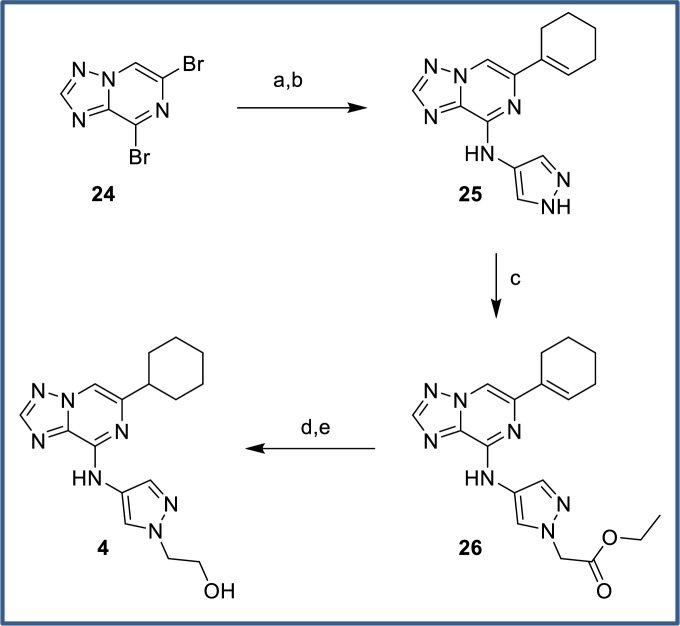
Synthesis of primary alcohol 4.Reagents and conditions: (a) 4-aminopyrazole hydrochloride, Et3N, DMF, 87%; (b) cyclohex-1-en-1-ylboronic acid, 2-(cyclohex-1-en-1-yl)-4,4,5,5-tetramethyl-1,3,2-dioxaborolane, PdCl2dppf, K3PO4, dioxane/water, 90°C, 46%; (c) ethyl 2-bromoacetate, K2CO3, DMF, 90°C, 45% (+ 31% recovered 25); (d) 10% Pd/C, H2 (1 atm), MeOH/EtOAc, rt, 84%; (e) LiAlH4, THF, 0°C to rt, 75%.